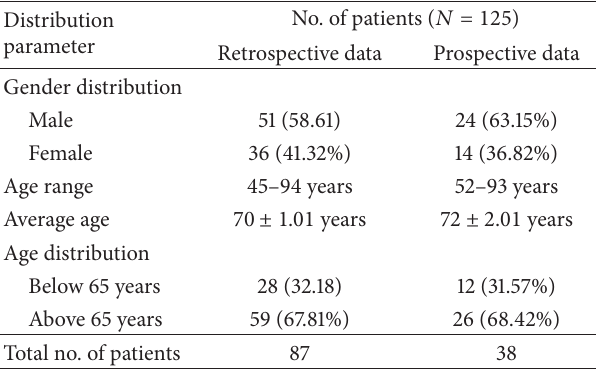
Table 1: Depiction of different demographic parameters of study population.